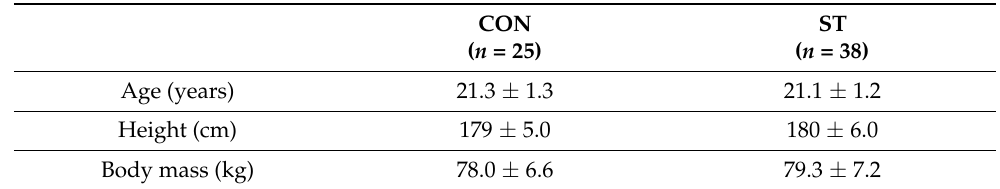
Table 1. Anthropometric characteristics of the control (CON) and swimming training group (ST) prior to (pre) 12-week study period.